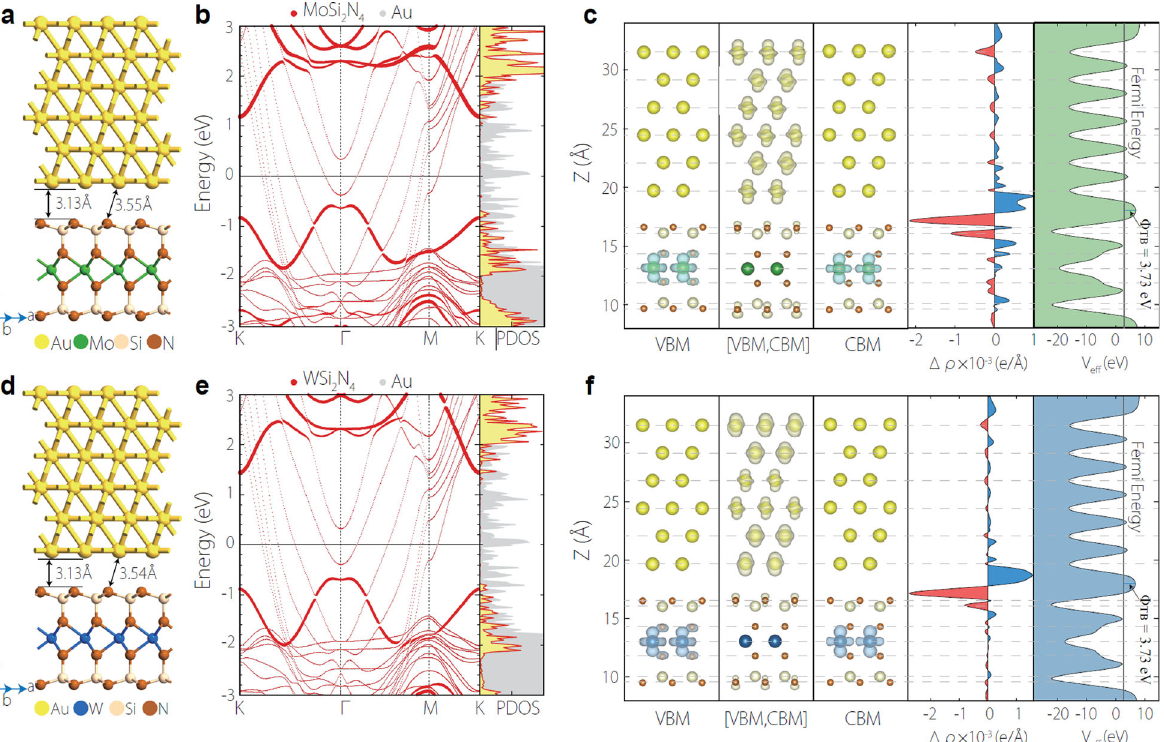
Fig. 2 Schottky contacts of Au/MoSi 2 N 4 and Au/WSi 2 N 4 - Structural and electronic properties. a The contact is composed of six layers of Au atoms contacting the MoSi 2 N 4 monolayer. The interlayer distance is 3.13 Å and the minimum distance between Au and N atoms is 3.55 Å . b The projected electronic band structure and the partial density of states of Au/MoSi 2 N 4 contact. The panels in c from left to right, show the spatial charge density distribution of VBM states, mid-gap states between VBM and CBM, and the CBM states, the differential charge density, and the electrostatic potential pro fi le across the heterostructures. d – f Same as a , b , and c , respectively, for Au/WSi 2 N 4 contact. The interlayer distance is 3.13 Å and the minimum distance between Au and N atoms is 3.54 Å